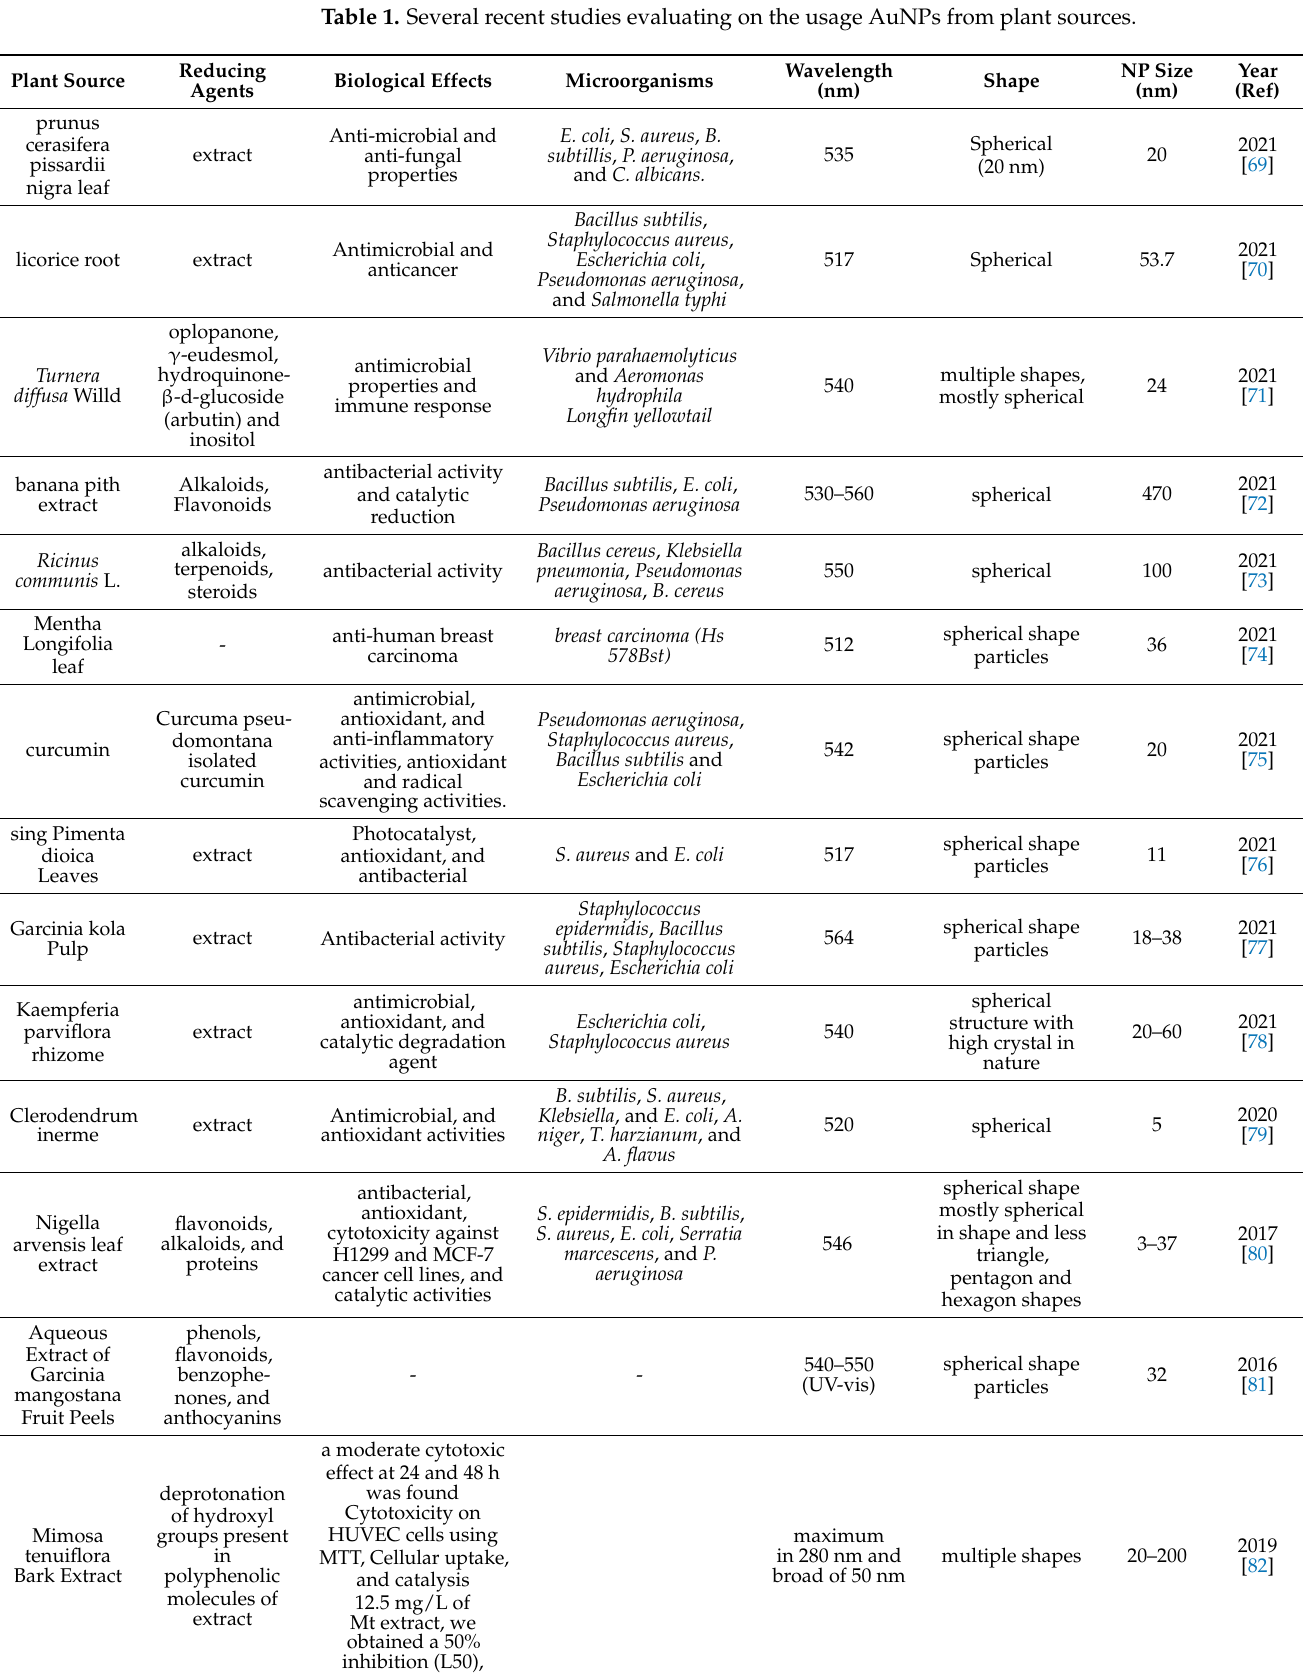
Table 1. Several recent studies evaluating on the usage AuNPs from plant